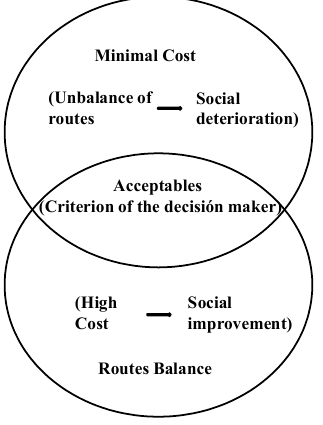
Fig. 4. Graphic analysis about obtained